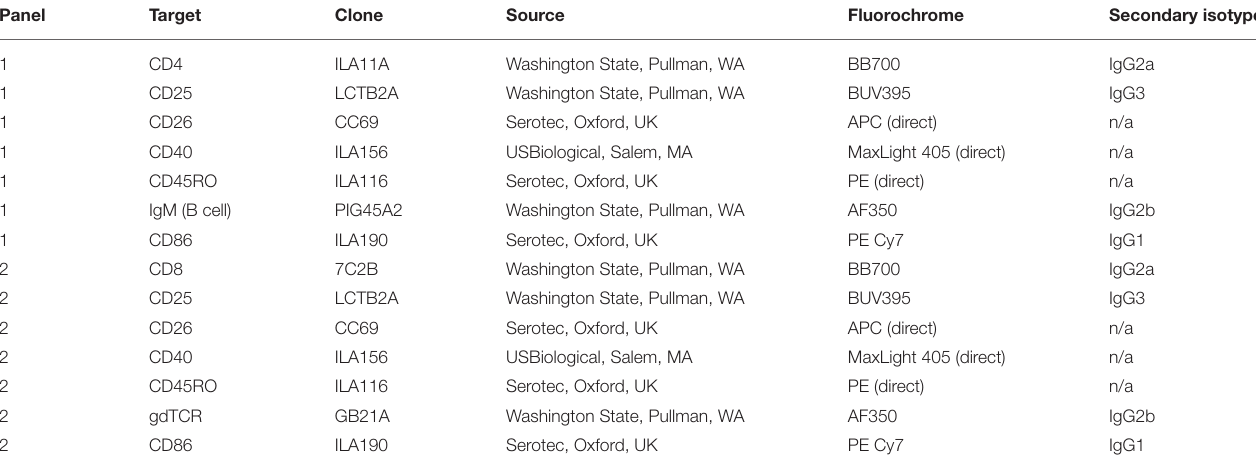
TABLE 1 | Flow cytometric analysis antibody panels. Panel